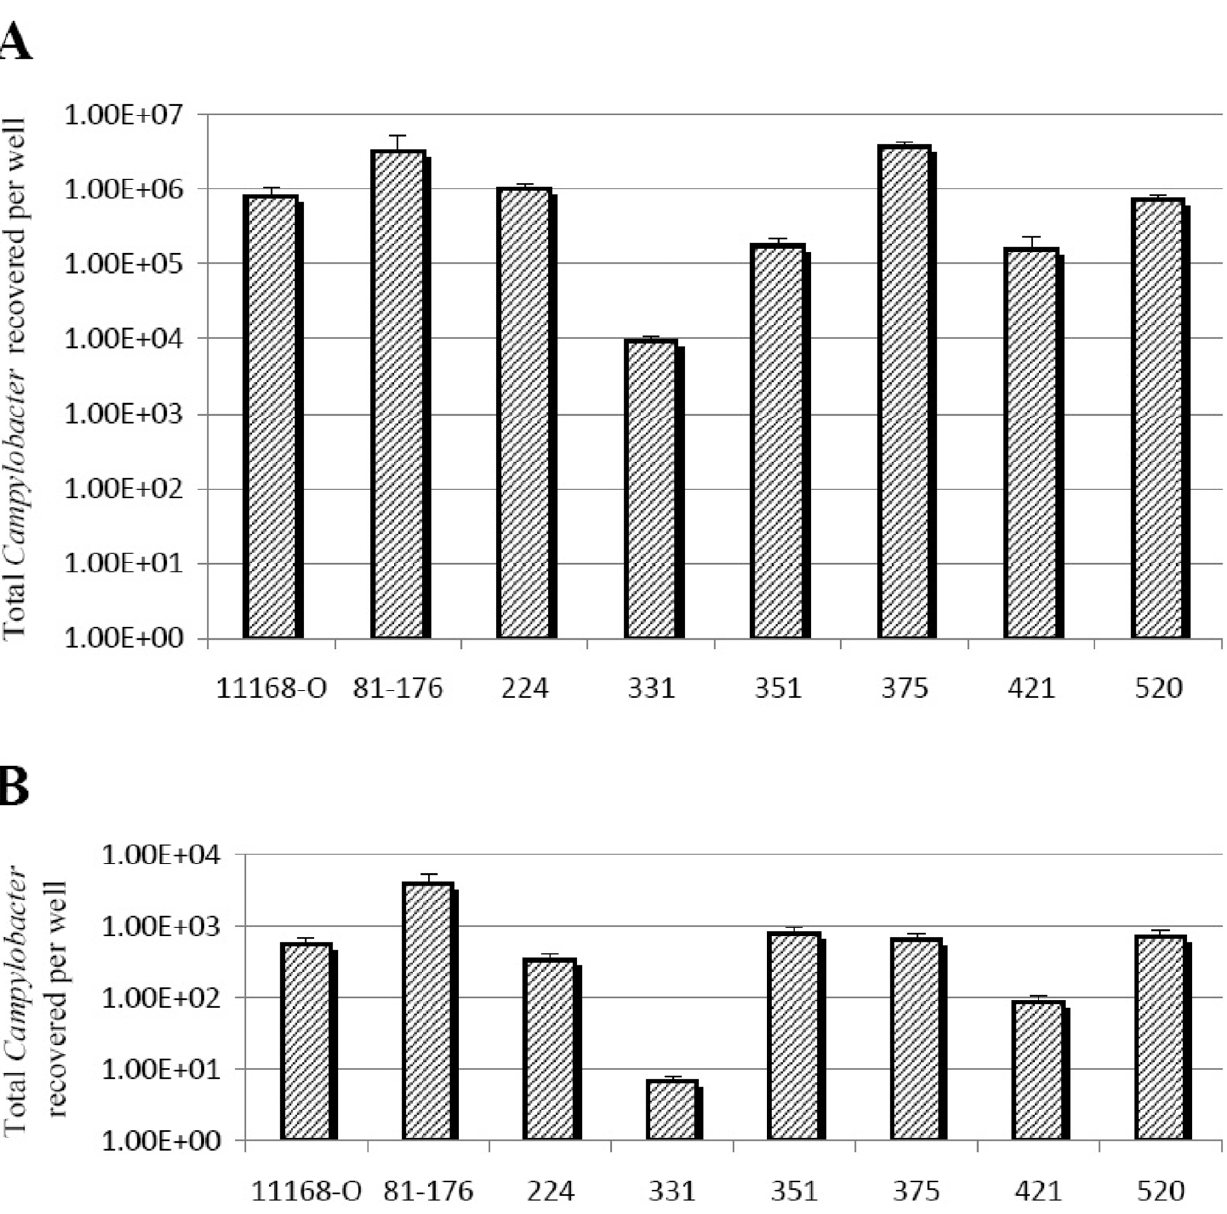
Figure 3. Adherence and invasion of C.jejuni strains. A) Adherence analysis of C. jejuni 11168-O, 81–176, 224, 331, 351, 375, 421 and 520 strains to CaCo-2 cells. B) Invasion analysis of C. jejuni 11168-O, 81–176, 224, 331, 351, 375, 421 and 520 strains into CaCo-2